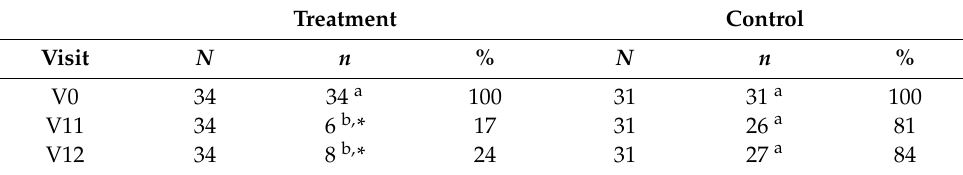
Table 5. Patients with neuropathic pain diagnosis according DN4 questionnaire total scores.